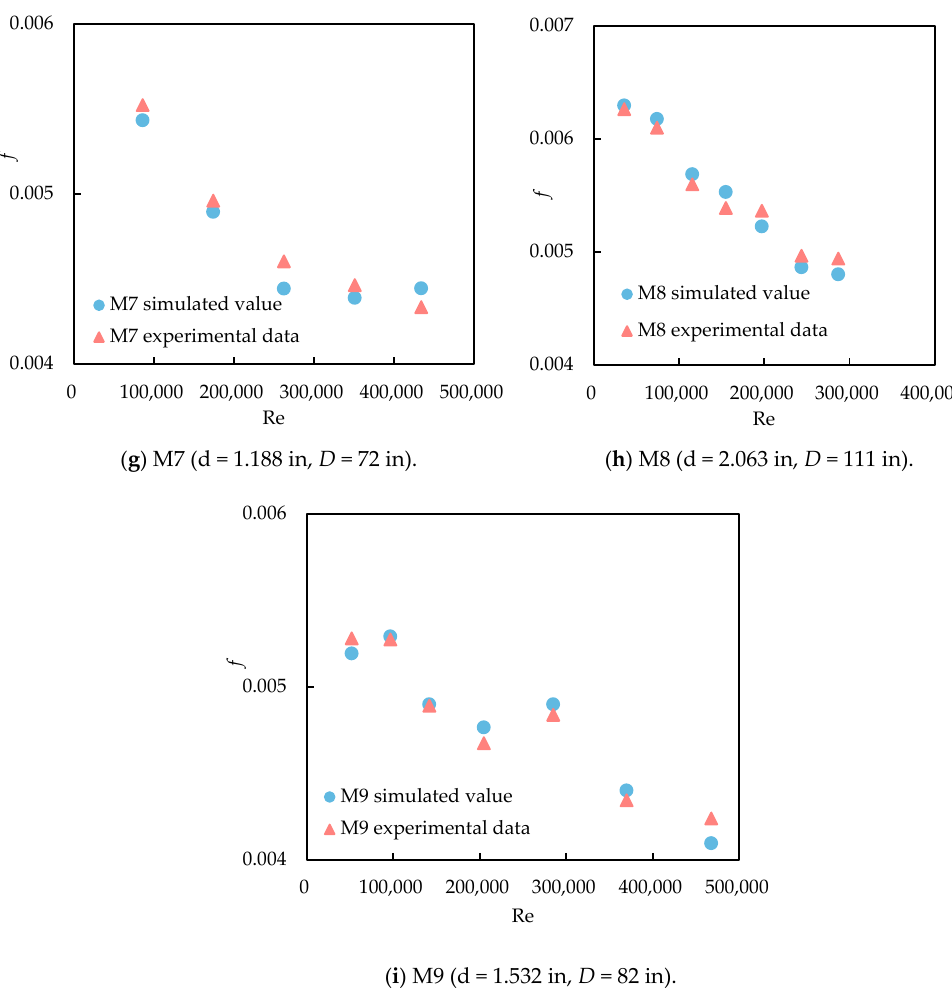
Figure 5. Comparison between the simulated and experimental friction factor for M1–M9 coiled tubing. Table 2. Average error and standard deviation between simulation and experimental values for M1–M9 coiled tubing.